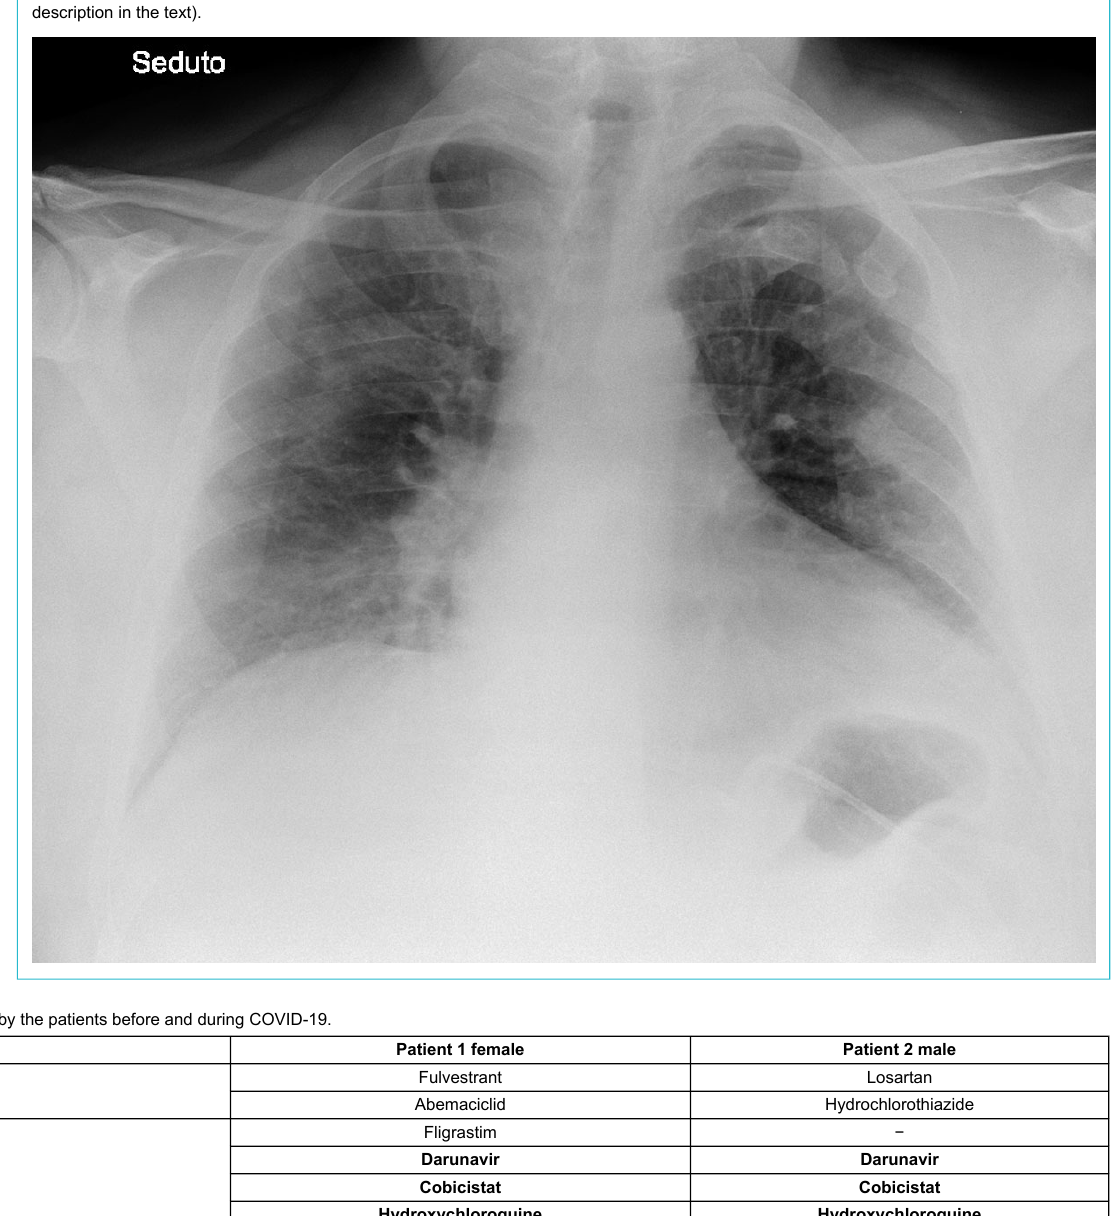
Figure 3: Chest x-ray of patient 2 on admission, 10 March 2020. Courtesy Ospedale di Sassuolo. Subpleural opacities dominate (see detailed description in the text).